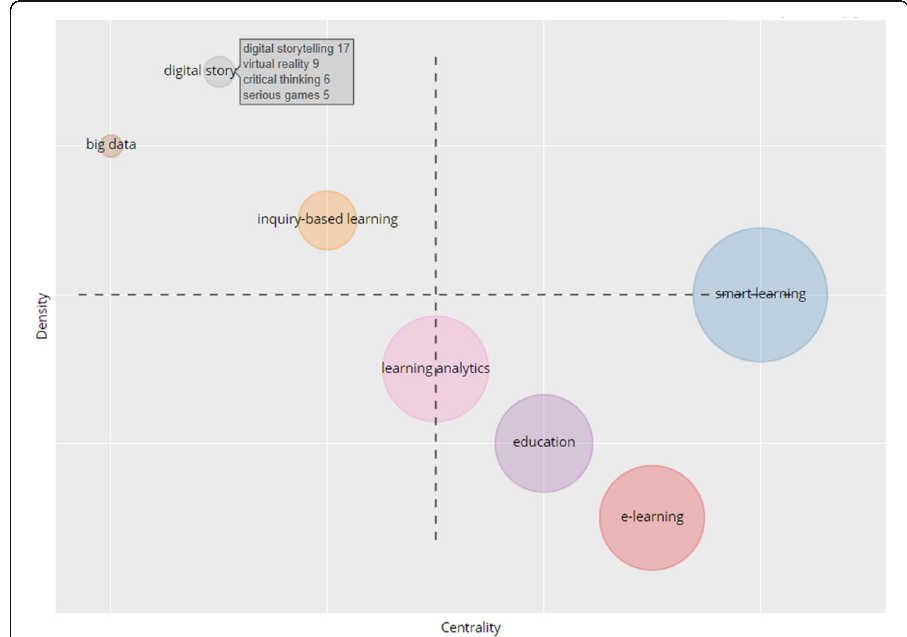
Fig. 12 Thematic map: Q1 contains the main theme, Q2 contains highly developed and specialized themes building ties with the leading theme; Q3 contains disappearing or emerging themes; Q4 consists of foundational and transversal